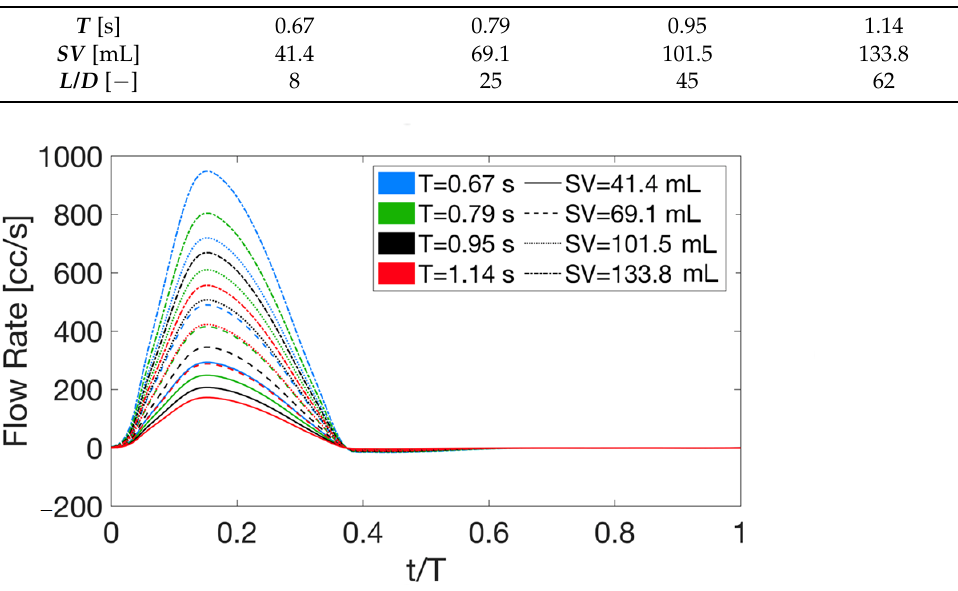
Figure 4. Waveforms of the inlet flow rate imposed through the pump of the circulatory mock loop for the stochastic sensitivity analysis to SV and T .